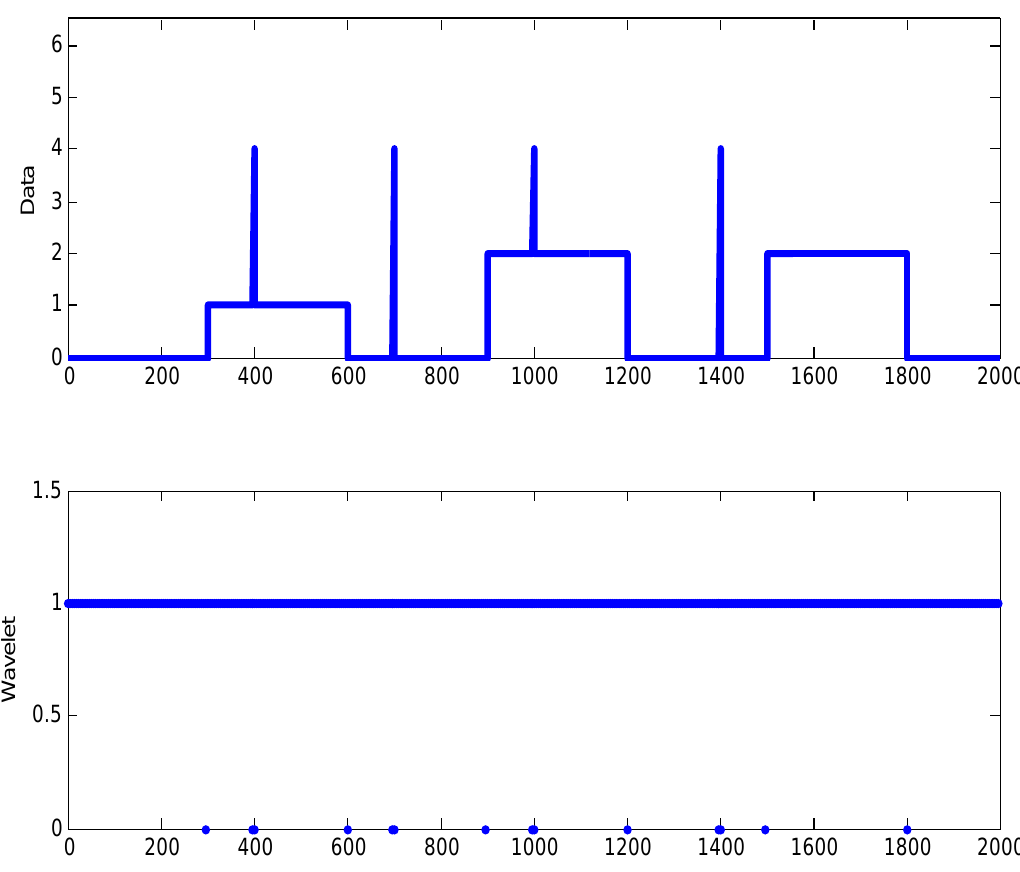
Figure 9. Case 2. Simulated data results for filtered data using the wavelet